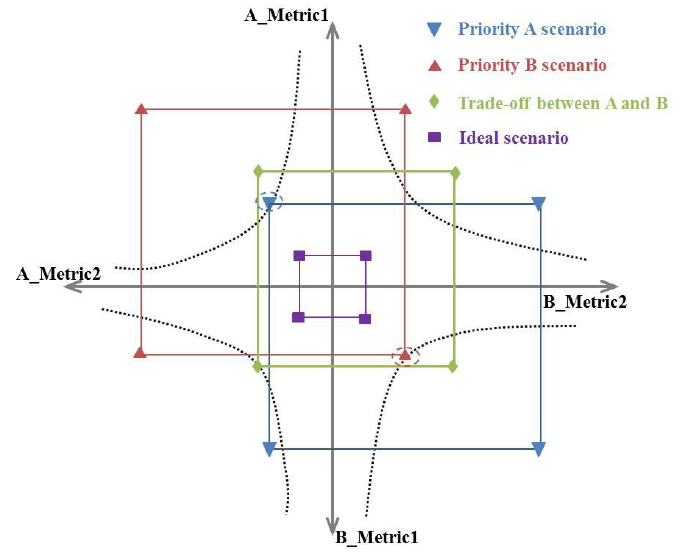
Figure 4. 4D plot for multi-objective based multi-scenario optimization